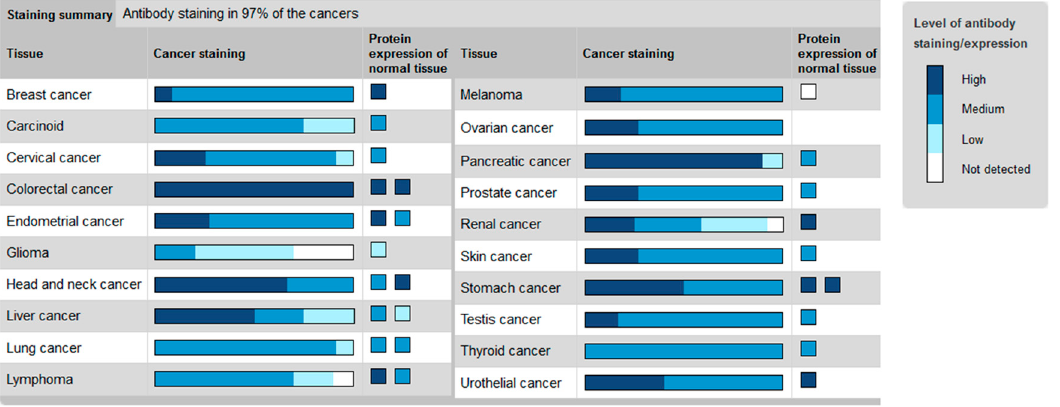
Figure 1. Ptch1 protein level in cancers. From the Protein Atlas website http://www.proteinatlas.org/ ENSG00000185920-PTCH1/cancer [40].